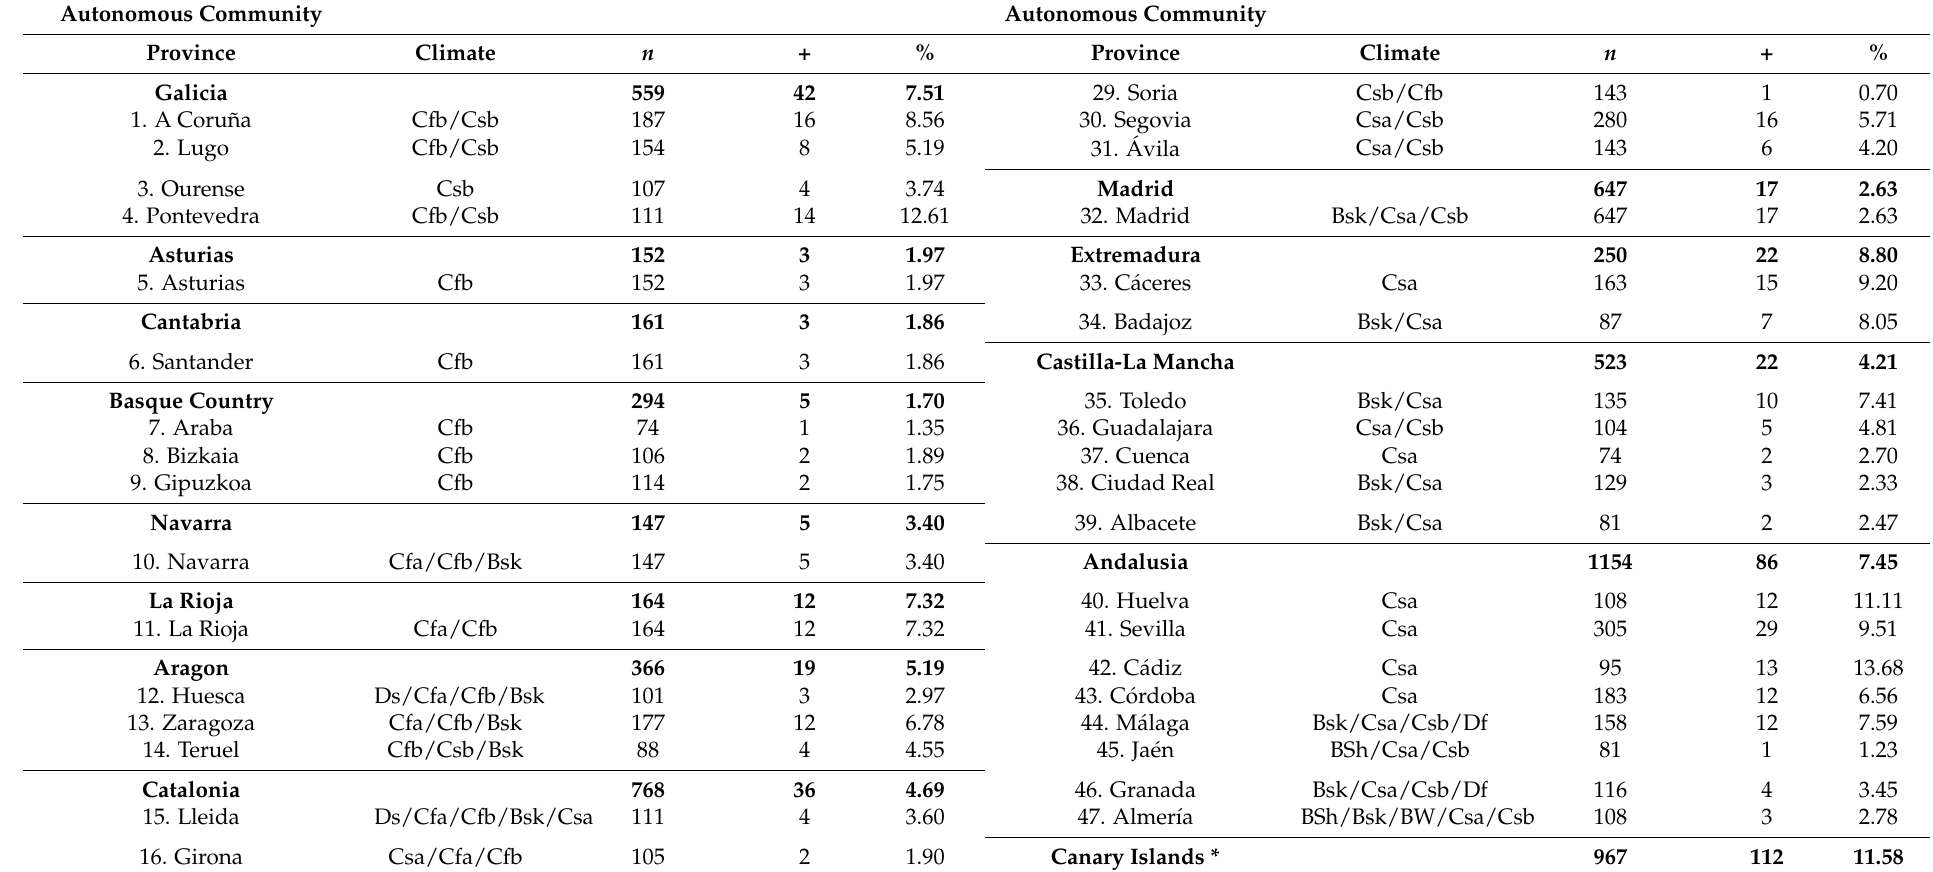
Table 1. Prevalences for D. immitis in domestic dogs in Spain by autonomous cities/provinces and climates (Köppen Climate Classification System). Abbreviations : n = number of dogs sampled; + = number of positive dogs; % = percentage of positive dogs. Legend: Csa: hot-summer Mediterranean climate; Cfb: temperate oceanic climate; Cfa: humid subtropical climate; Csb: warm-summer Mediterranean climate; Bsk: cold semi-arid climate; BSh: hot semi-arid climate; BWh: hot desert climate. (*) Note: the regions under Canary Islands and Balearic Islands do not correspond to provinces, but to islands. Ceuta and Melilla are autonomous cities, not part of any autonomous